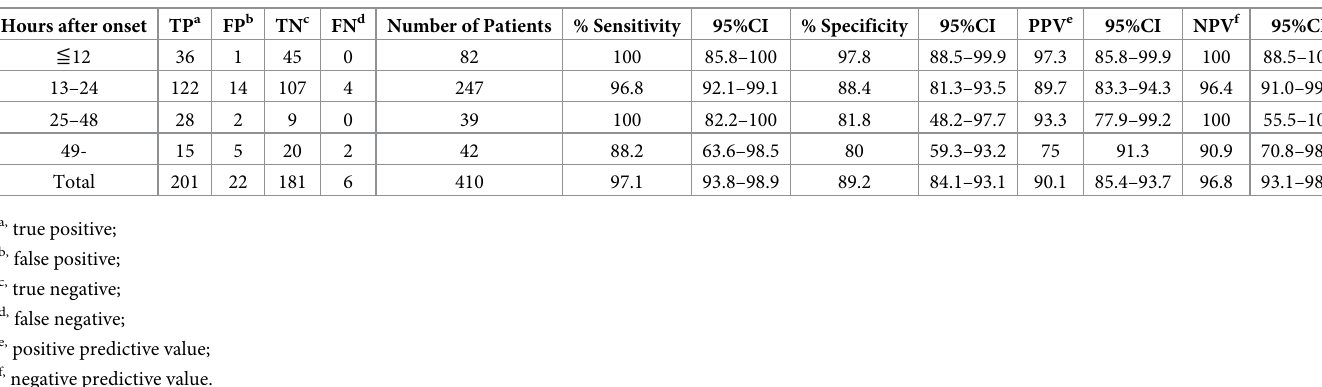
Table 3. Sensitivity and specificity of ImunoAce Flu according to time after the onset of